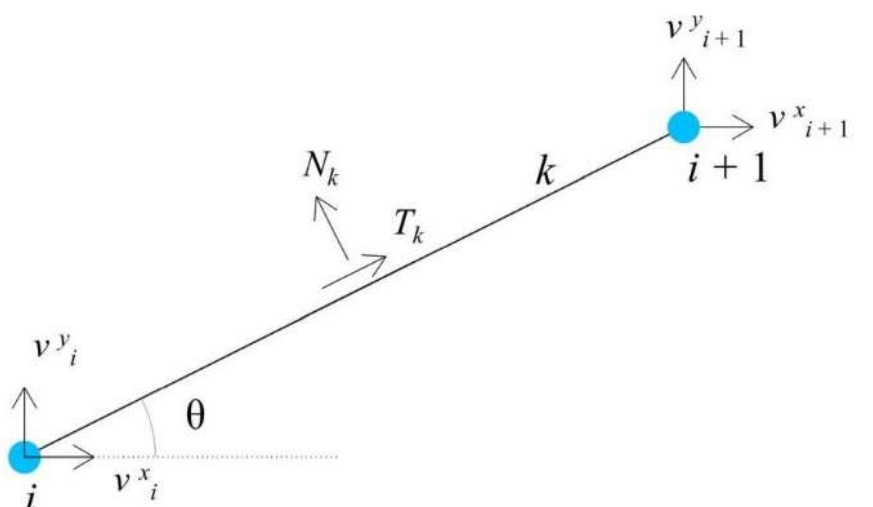
Figure 8. An equilibrated interface, with the tangential and normal forces acting on the interface as well as horizontal and vertical forces acting on the interface endpoints.